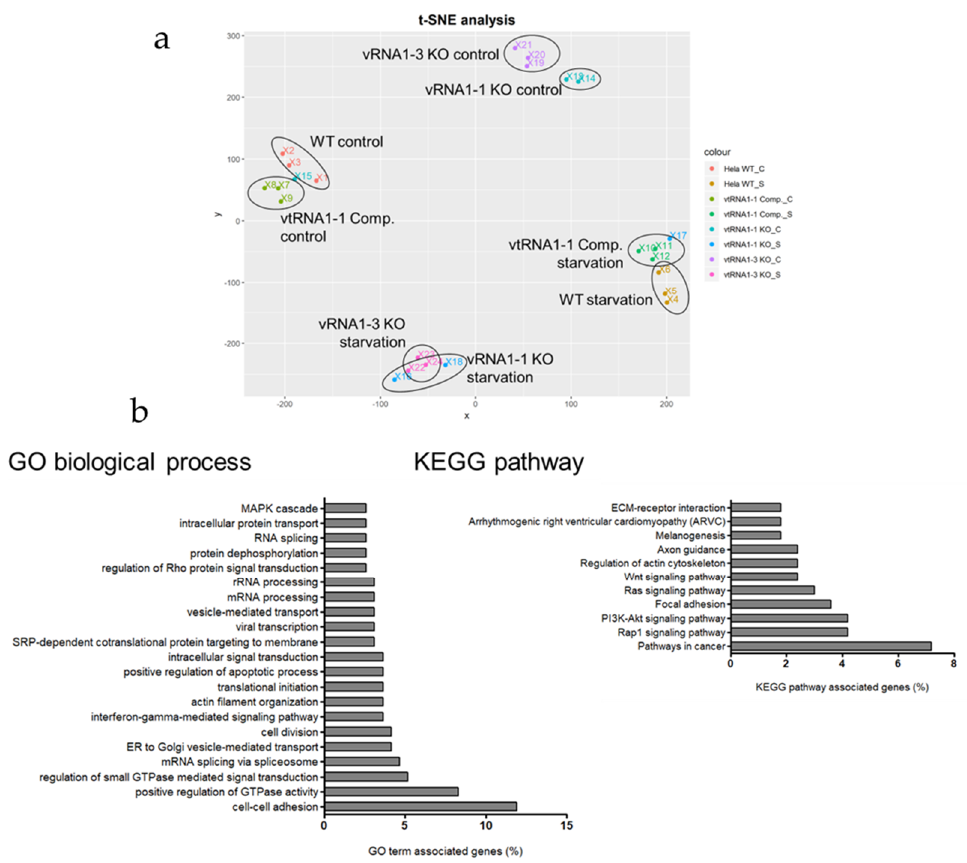
Figure 2. vtRNA1-1 loss leads to increased cellular signaling activity under starvation. ( a ) T-distributed Stochastic Neighbor Embedding (t-SNE) analysis of the mRNAseq data performed with all genes. vtRNA1-1 knock-out control sample #15 and vtRNA1-1 knock-out starvation sample #17 were excluded for all further downstream analyses. ( b ) Database for annotation, visualization, and integrated discovery (DAVID) gene ontology (GO) analysis and KEGG pathway analysis performed on 167 genes di ff erentially expressed specifically in the vtRNA1-1 knock-out cells following 24 h of starvation with chloroquine. The functional annotation clustering application was used to determine important GO and KEGG